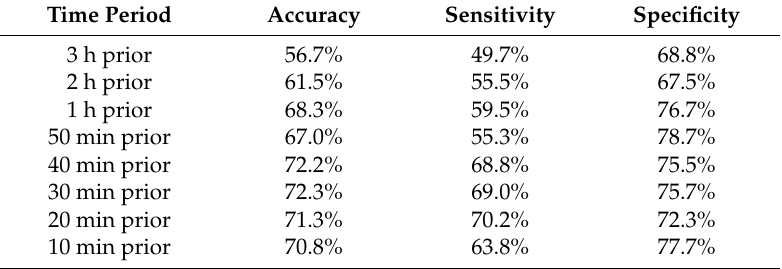
Table 1. Tabular summary of the accuracy, sensitivity, and specificity of the linear classifier. Time Period